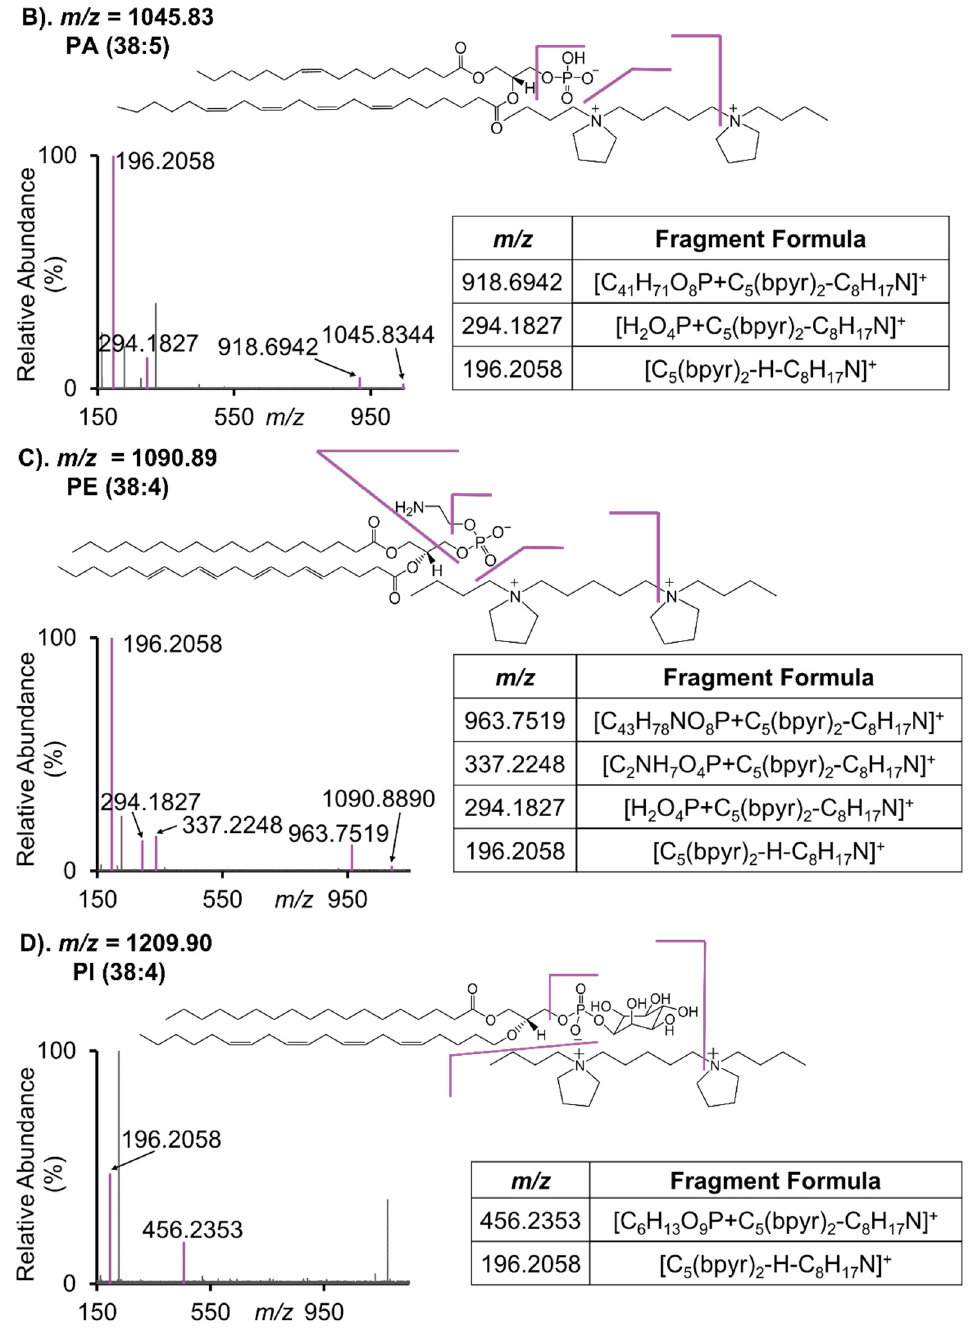
Figure 6. MS/MS mass spectra of selected adducted ions with their putative identifications and structures. ( A ). [FA(18:2)-H+C 5 (bpyr) 2 ] + ; ( B ). [PA(38:5)-H+C 5 (bpyr) 2 ] + ; ( C ). [PE(38:4)-H+C 5 (bpyr) 2 ] + ; ( D ). [PI(38:4)-H+C 5 (bpyr) 2 ] + , noting that the fragment peak at 1082.7628 m / z was not seen in the spectra possibly due to the low abundance of its precursor ion at 1209.8991 m / z